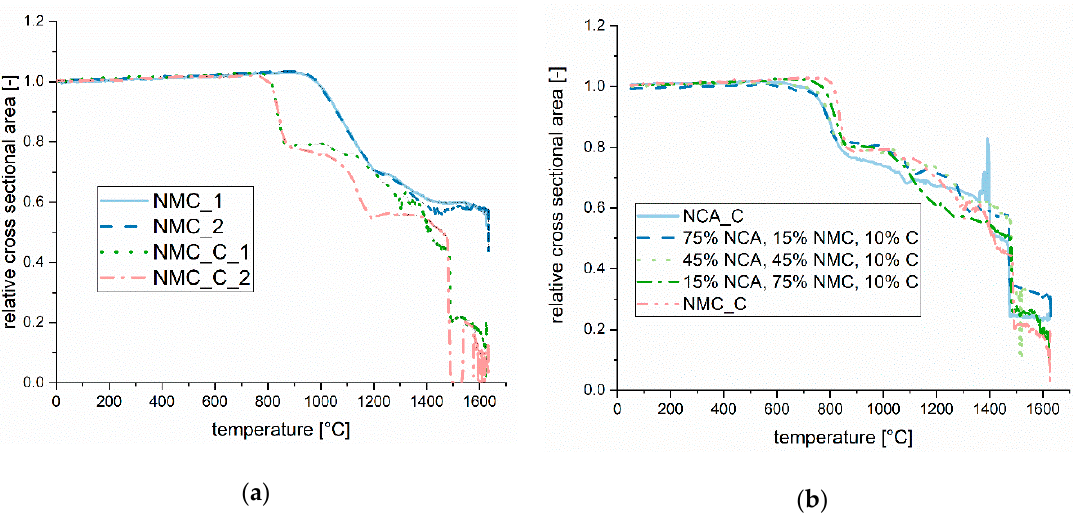
Figure 3. ( a ) Comparison of the cross sectional area of NMC with and without carbon addition in the heating microscope; ( b ) Comparison of the cross sectional area of different mixtures of NMC and NCA, each with carbon addition.